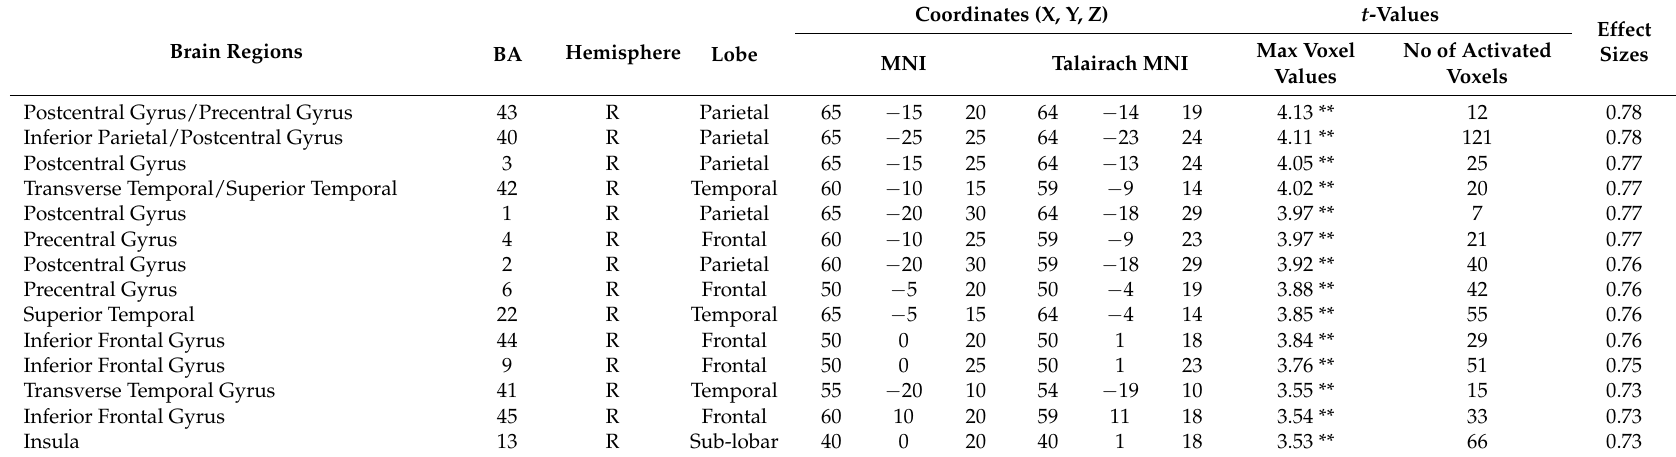
Table 3. Standardized low-resolution brain electromagnetic tomography (sLORETA) results of maximal brain electrical activity for the oddball effect (rare vs. frequent: 402 ms latency) for the BFRB group.